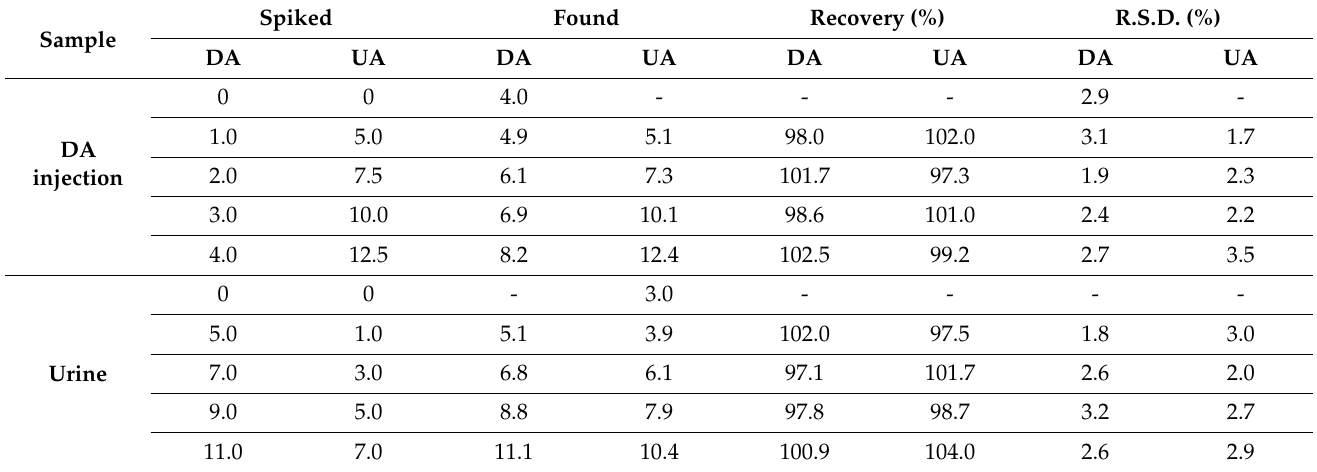
Table 3. Voltametric sensing of DA and UA in real specimens using CoMOF-GO/1-M,3-BB/CPE. All concentrations are in µ A (n = 5).